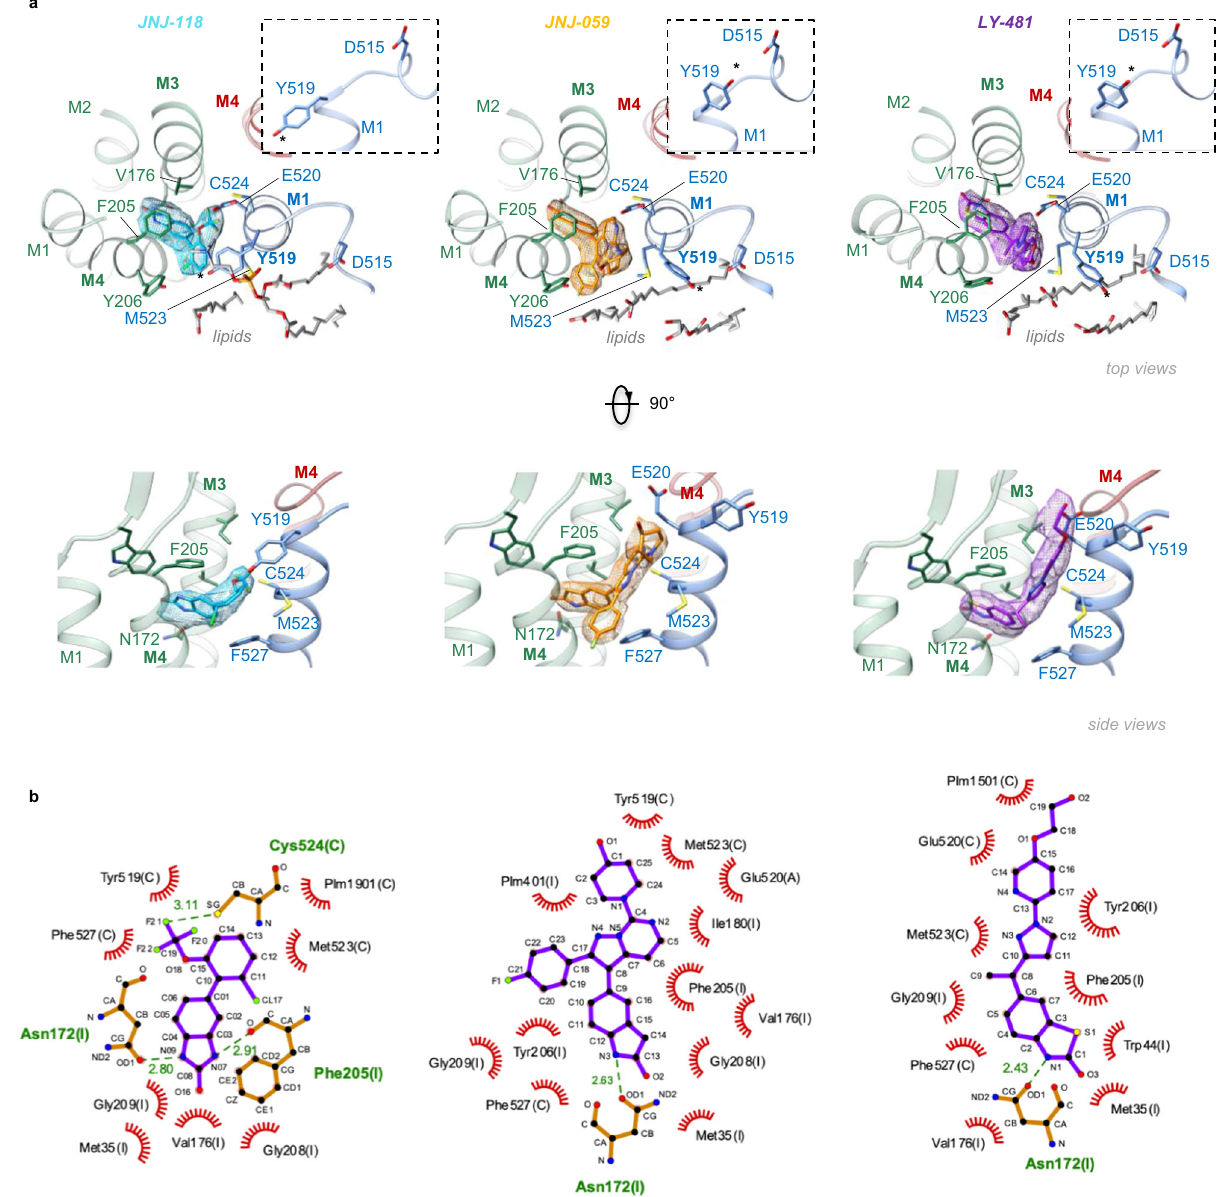
Fig. 2| NAMbindingpocketsand coordinatingresidues.a Top panels:Top view onto the NAM pockets. TARP γ 8 is shown in green, AMPAR helices are blue (GluA1 M1) and red (GluA2 M4), the three NAMs are colour-coded. Ligand-interacting residues and lipids are shown in stick. The insets show side views onto Tyr519,